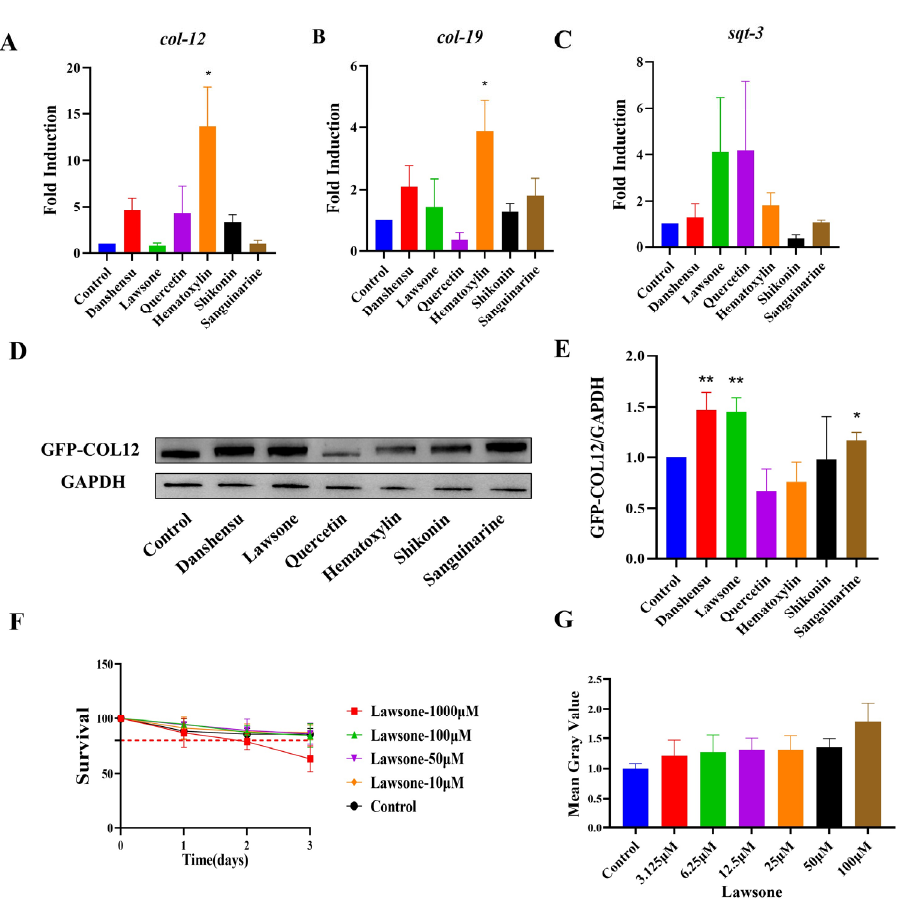
Figure 6. Quantitative analysis of compound-promoted COL-12 expression ( A – C ) Effects of different compounds on transcript levels of different collagen encoded genes (* p < 0.05 for the designated treatment vs. Control), n = 3; ( D , E ) Effects of different compounds on COL-12 expression level (* p < 0.05, ** p < 0.01 t test for the designated treatment vs. Control), n = 3; ( F ) Nematode survival rate, n = 3; ( G ) The quantitative ‐ effect relationship of Lawsone, n = 3.